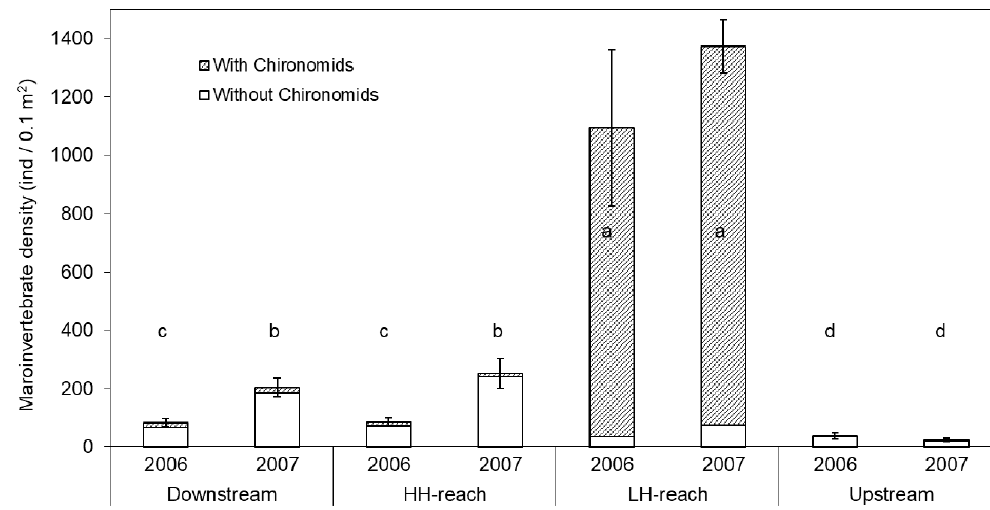
Figure 3. Average macroinvertebrate density (DENSITY), including and excluding Chironomids, from five Surber samples per reach per year. Error bars show ± 1 SE for total DENSITY only. Groups with the same letter (i.e., a–d) are not significantly different (based on total DENSITY; α = 0.05) according to Duncan’s Multiple Range Test.